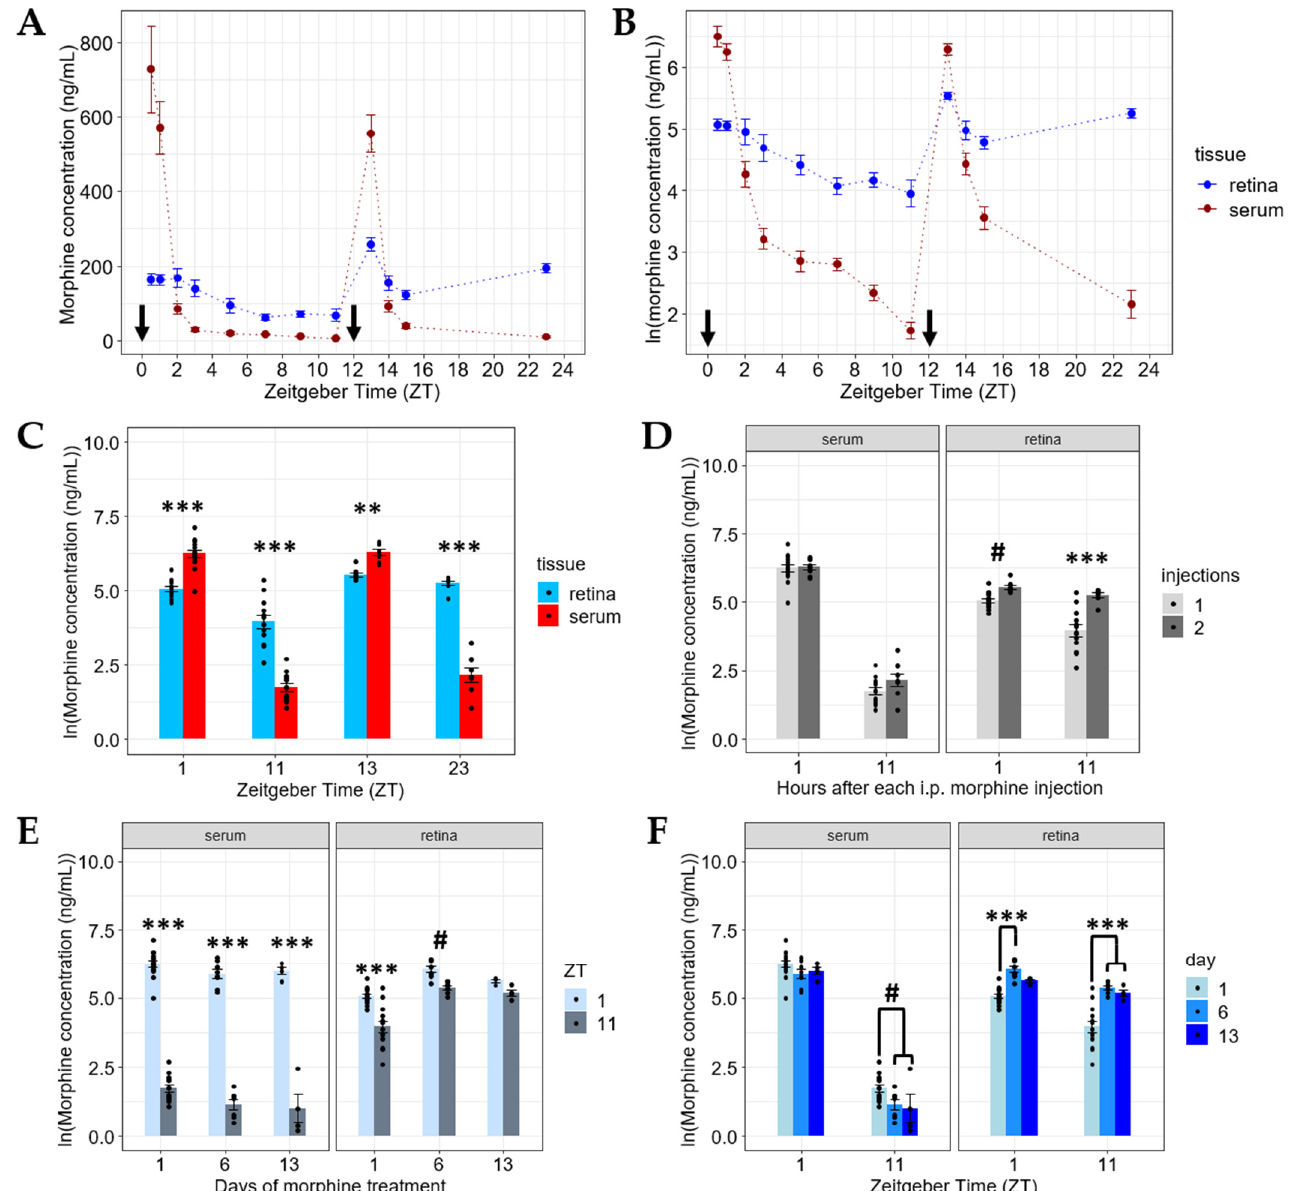
Figure 2. Morphine accumulates in the retina following repeated systemic exposure. ( A ) Morphine pharmacokinetics in retina and serum following 20 mg/kg i.p. morphine injections at ZT 0 and ZT 12 (indicated by arrows). ( B ) Morphine concentrations in retina and serum following systemic injections at ZT 0 and ZT 12 (indicated by arrows) on the natural logarithmic (ln) scale. Significant differences exist between the retina and serum within each measured time point ( p < 0.01). Two-way ANOVA was used with a Tukey post hoc adjustment for the ln scale. ( C ) Morphine concentration in the serum is higher than in the retina 1 h (ZT 1 and ZT 13) after 20 mg/kg i.p. morphine injections at ZT 0 and ZT 12 (at the selected time points from the data shown in B ). However, the retinal morphine levels exceed the serum levels at 11 h after systemic exposure (ZT 11 and ZT 23). Two-way ANOVA with a tissue x ZT interaction and a Tukey post hoc adjustment was performed on the ln scale. ( D ) Serum morphine pharmacokinetics remain the same at 1 and 11 h after one and two 20 mg/kg i.p. morphine injections, while the retinal morphine levels increased following the second injection at those same time points. Three-way ANOVA with a tissue x hours post-injection x injection number interaction and a Tukey post hoc adjustment was performed on the ln scale. ( E , F ) Morphine appears to accumulate in the retina following 6 or 13 days of chronic systemic morphine treatment, while the serum pharmacokinetics remain similar for ZT 1 and ZT 11. Three-way